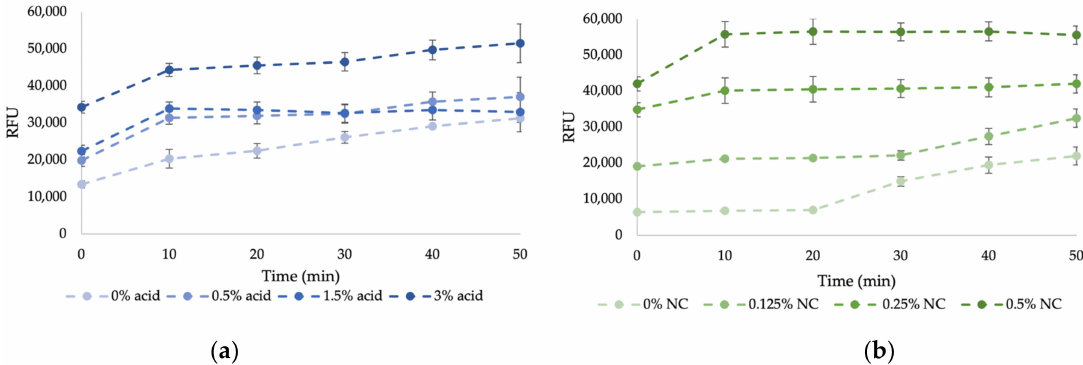
Figure 4. ( a ) RFU of 0.5% NC in varying sulfuric acid concentrations and ( b ) RFU of varying NC concentrations in 3% sulfuric acid. Each curve represents a different NC and sulfuric acid mixture, with a fixed 0.4% KOH (pH = 13) and 0.1%